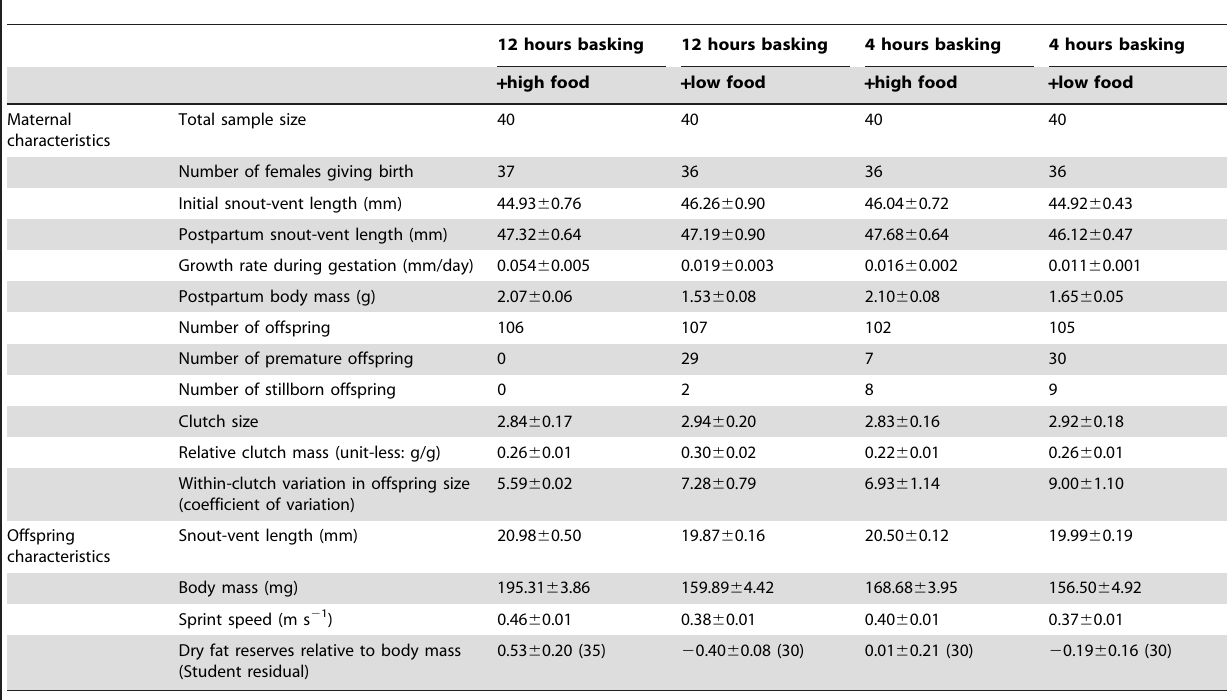
Characteristics of maternal Pseudemoia entrecasteauxii including snout-vent length, growth rate during gestation, body mass, clutch size, relative clutch mass and within-clutch variation in offspring size, and characteristics of offspring Pseudemoia entrecasteauxii from females given combinations of extended and restricted basking opportunities and food supply during gestation including snout-vent length, body mass, sprint speed and fat reserves relative to body mass at birth. Values are means 6 S.E. ( n ).